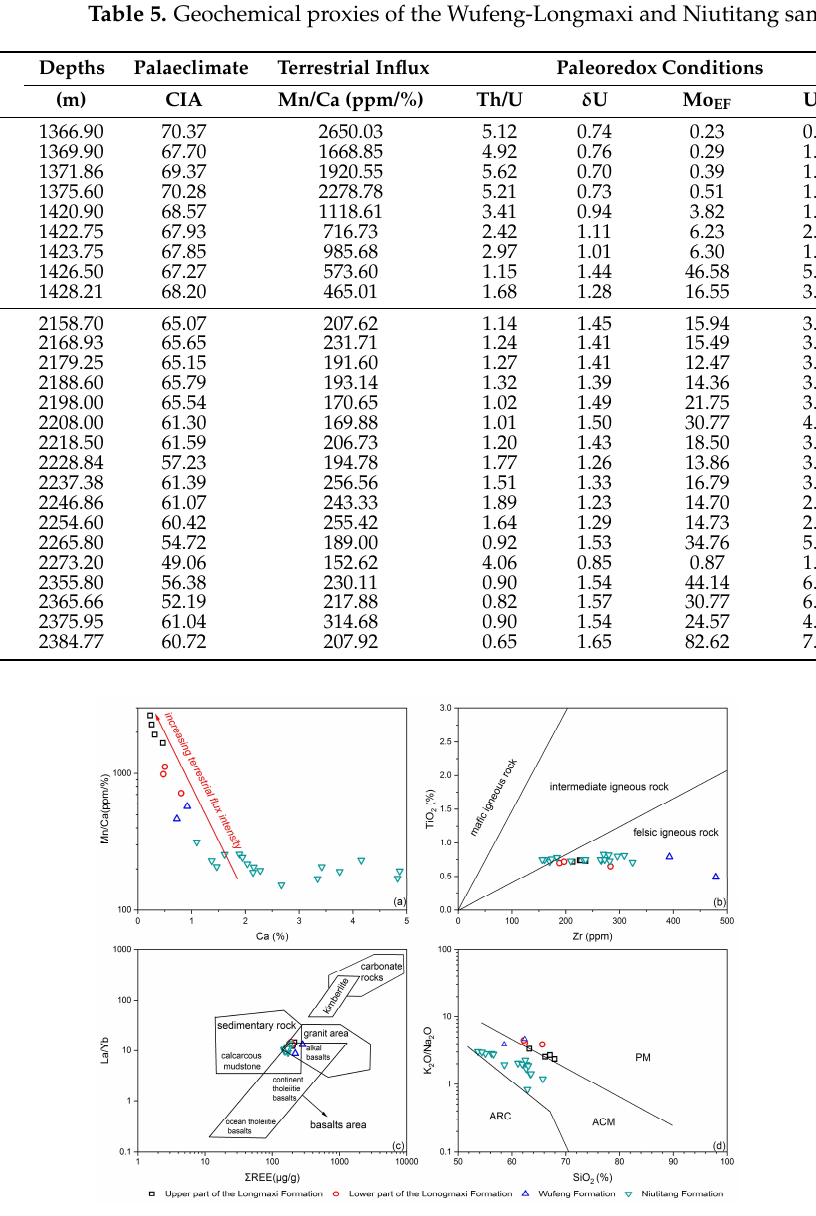
Figure 5. ( a ) Mn/Ca (ppm/%) versus Ca (%) for samples from different formations. ( b ) TiO 2 versus Zr for samples from different formations. The interpretation lines are from Hayashi et al., (1997) [41] . ( c ) La/Yb versus ΣREE for samples from different formations. The interpretation lines are from Zhao (2016) [44] . ( d ) K 2 O/Na 2 O versus SiO 2 for samples from different formations. The interpretation lines are from Roser and Korsch (1986) [45] . ARC: oceanic island arc margin; ACM: active continental margin; PM: passive margin.